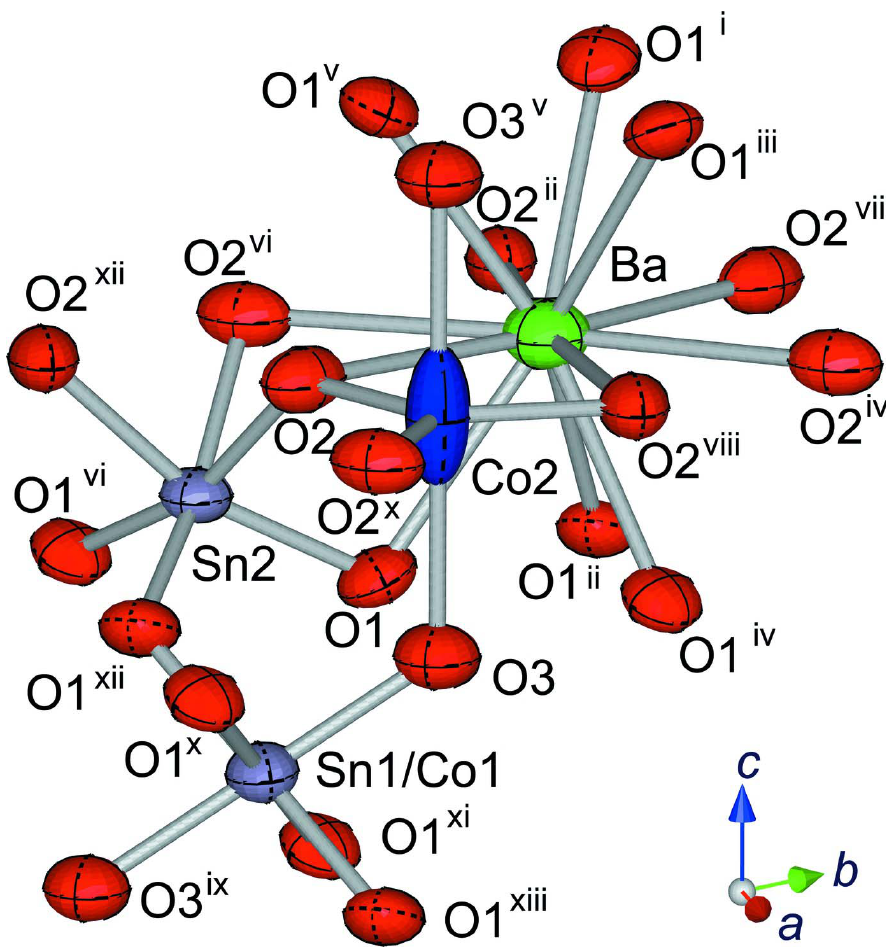
Sn O (symmetry codes as in Table 1). Displacement ellipsoids 2 4 11